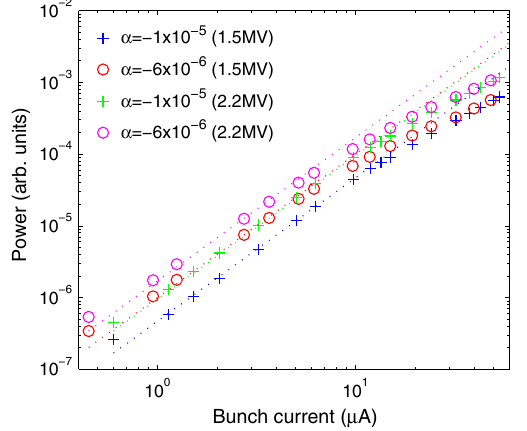
FIG. 11. Bunch profiles recorded with the streak camera for